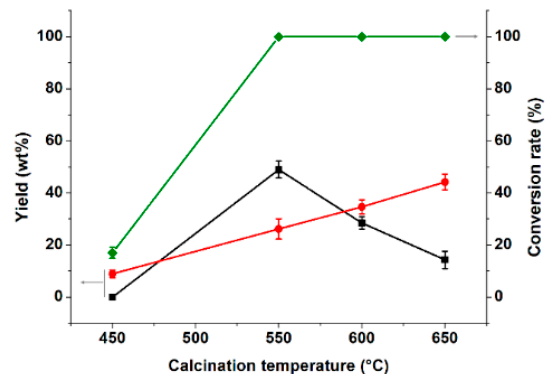
Figure 4. Effect of catalyst calcination temperature on the yields of dimeric products ( ■ ) and camphene ( ● ) and the conversion rate of α -pinene ( ◆ ). All the other reaction conditions were maintained for 3 h at 120 °C.